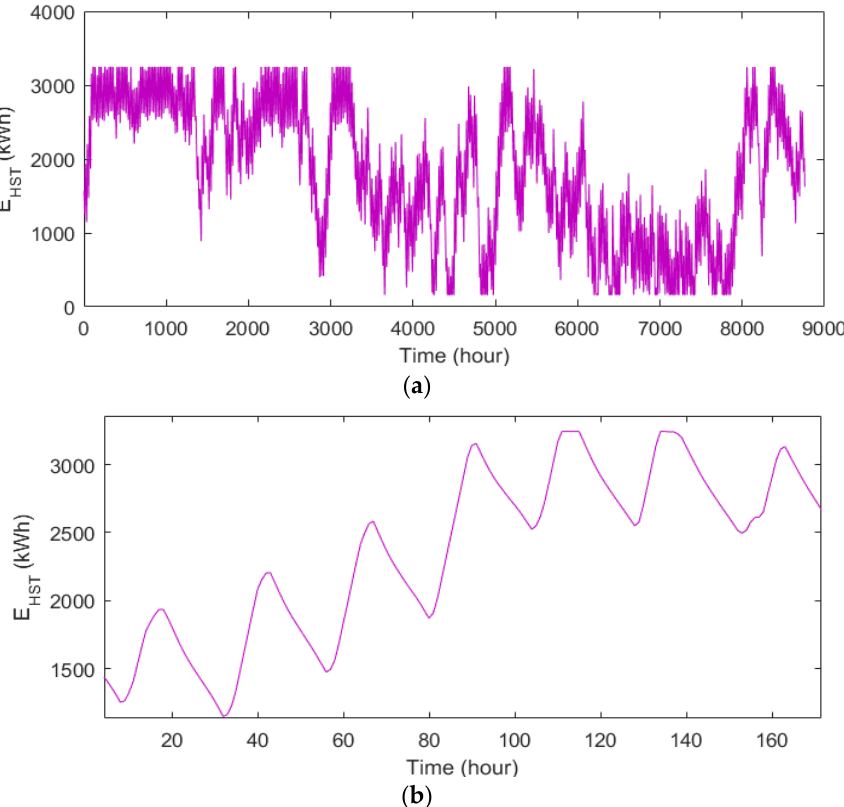
Figure 14. Hydrogen storage tank energy considered in the sizing of the HPV/FC energy system via the IAEO, considering ENSP max = 5% during ( a ) a year and ( b ) a